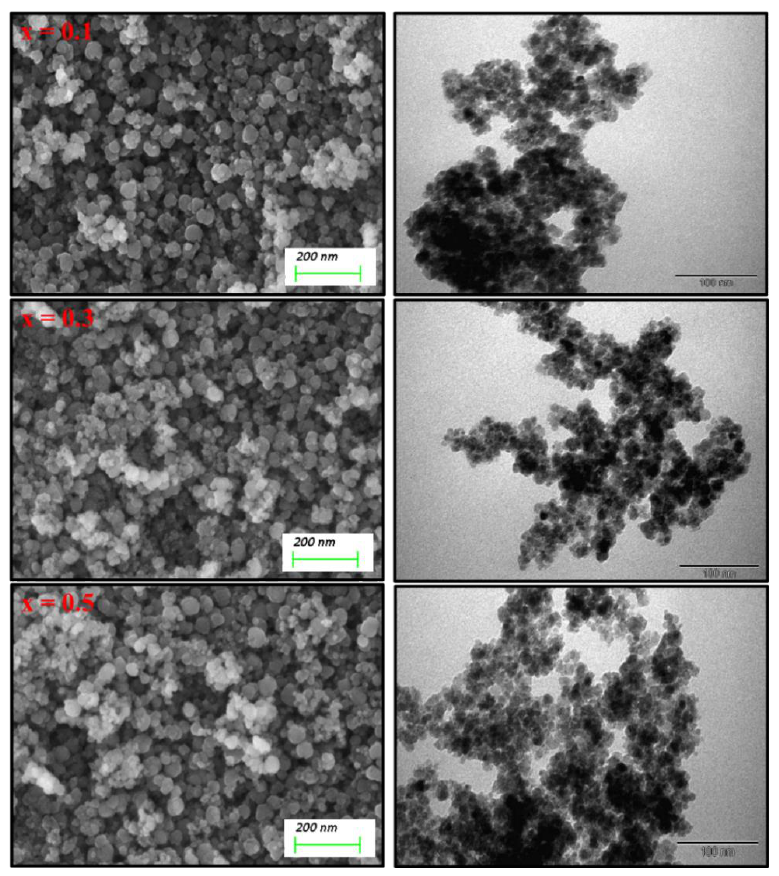
Figure 2. SEM and TEM images of (Mn 0.5 Zn 0.5 )[Cd x Fe 2− x ]O 4 (x = 0.1, 0.3 and 0.5) NSFs.